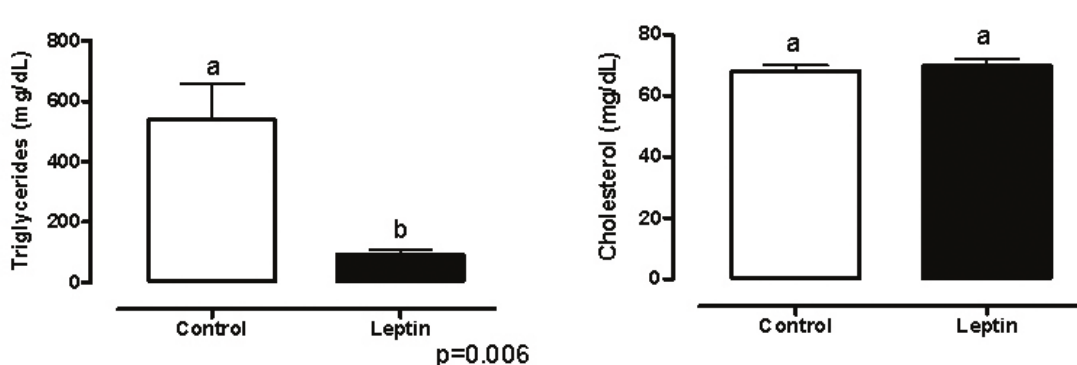
FIGURE 3 - Triglycerides and cholesterol serum levels in control and leptin treated groups. Values are given as mean ±SEM of 6 animals